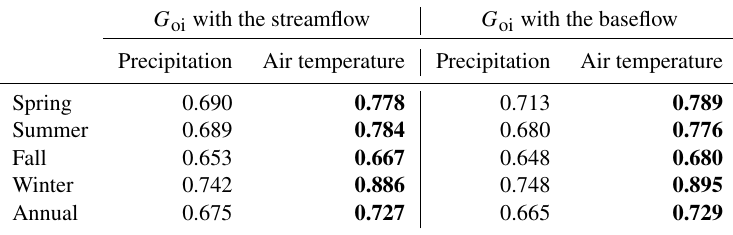
Table 2. Gray relational grades between the streamflow/baseflow and climate factors ( G oi ; precipitation and air temperature) in the Yangba- jain Catchment at both the annual and seasonal scales. Bold text shows the higher gray relational grade in each season. G oi with the streamflow G oi with the baseflow